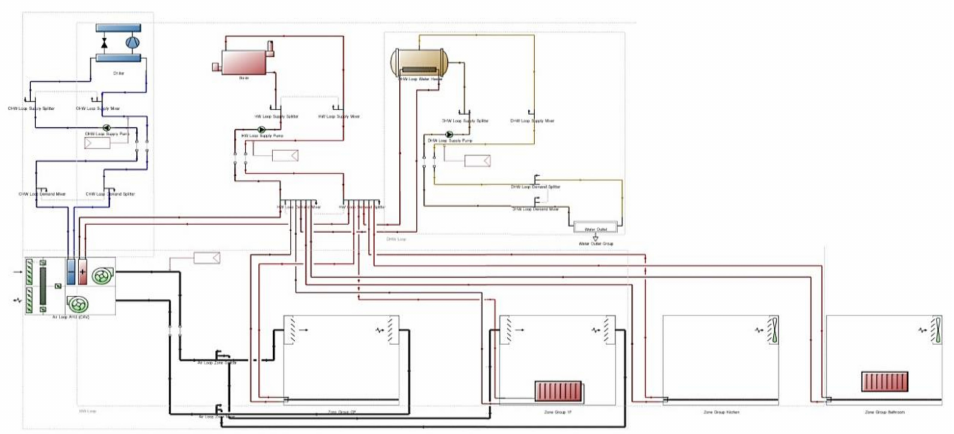
Figure 6. HVAC system developed in DesignBuilder software.